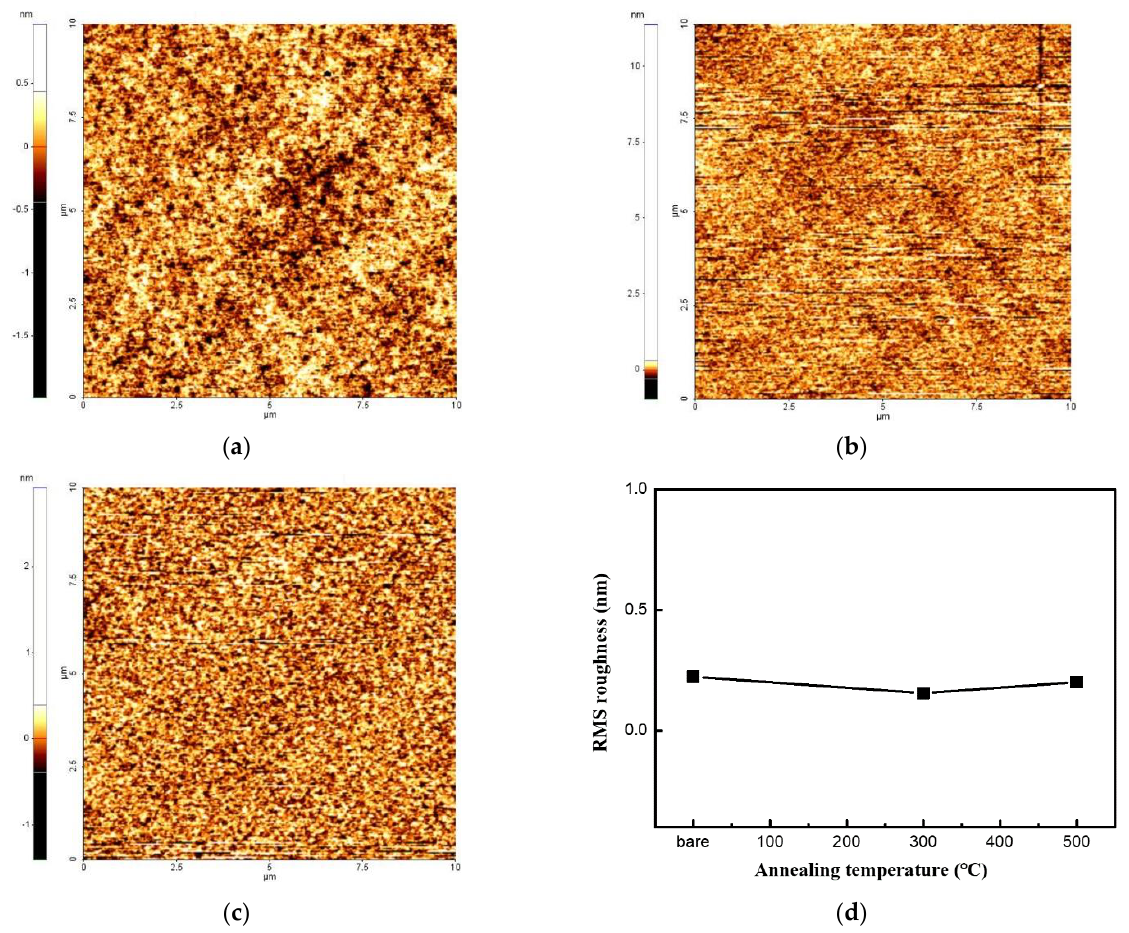
Figure 4. AFM images of the ( a ) as-deposited NiO film and NiO films annealed at ( b ) 300 °C and ( c ) 500 °C. ( d ) RMS roughness vs. the annealing temperatures.